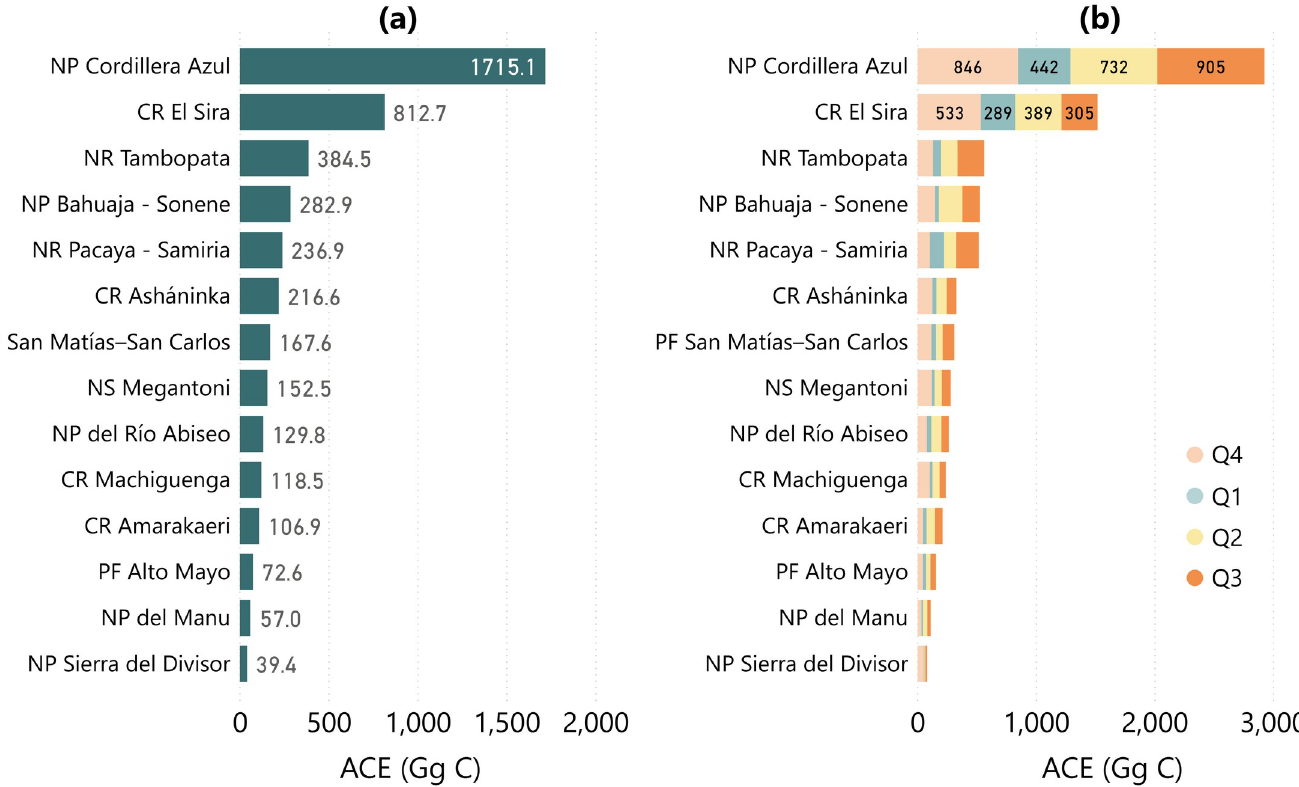
Fig 8. Buffer zones of national protected areas with (a) high annual ACE (in Gg C) and (b) the quarterly ACE results for these areas (in Gg C). Abbreviations: National Park (NP), National Reserve (NR), Communal Reserve (CR), Protection Forest (PF), National Sanctuary (NS). Note that 1,000 Gg C = 1 Tg C.